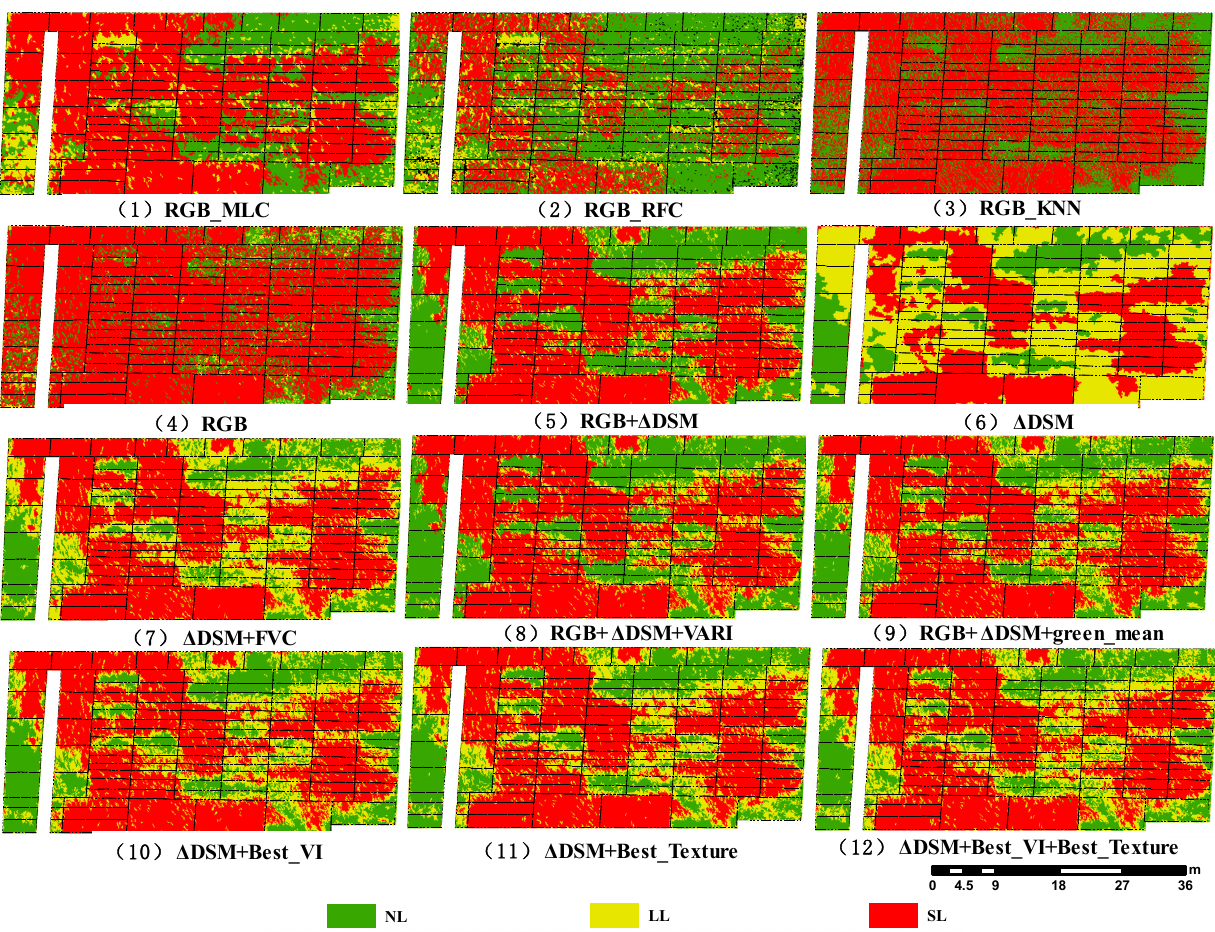
Figure 14. Classification of degree of lodging of maize by various combinations of characteristic bands and classification methods. Because the image is too large, the most serious lodging species and density of plot classification were displayed. The object-oriented classification method reduces the classification fragmentation and recognizes LL, thus improving the classification accuracy.